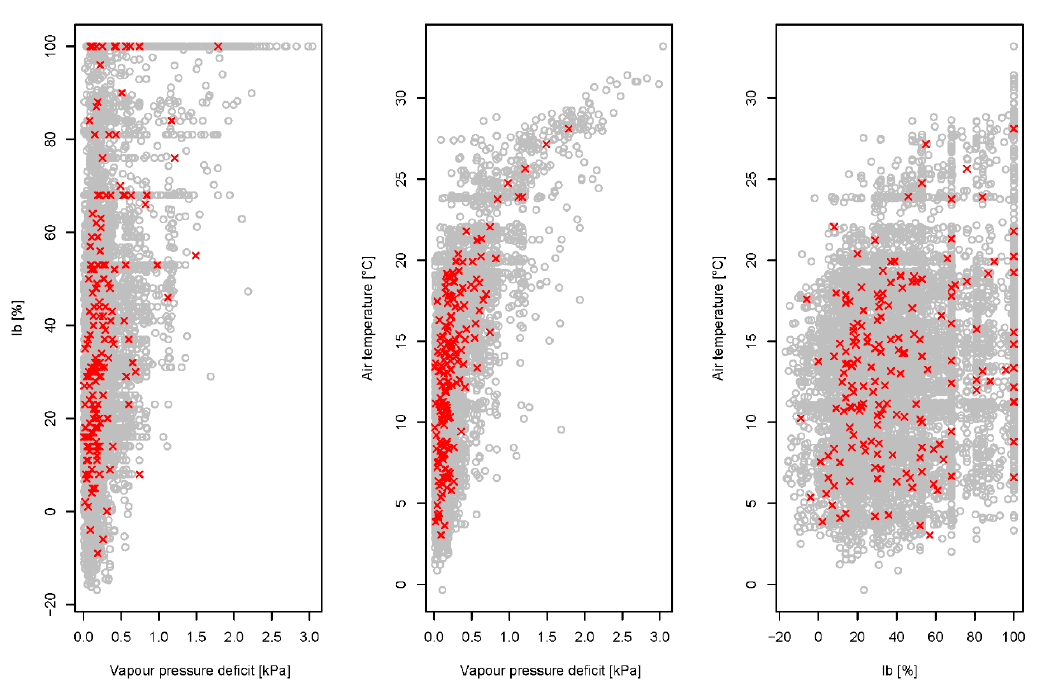
Figure 4. Graphical fit for birch trees between measured data (red crosses) and 10,000 random realizations (grey circles) using the copula model where the Joe copula was selected as C 1 and the Gumbel-Hougaard copula was selected as C 2